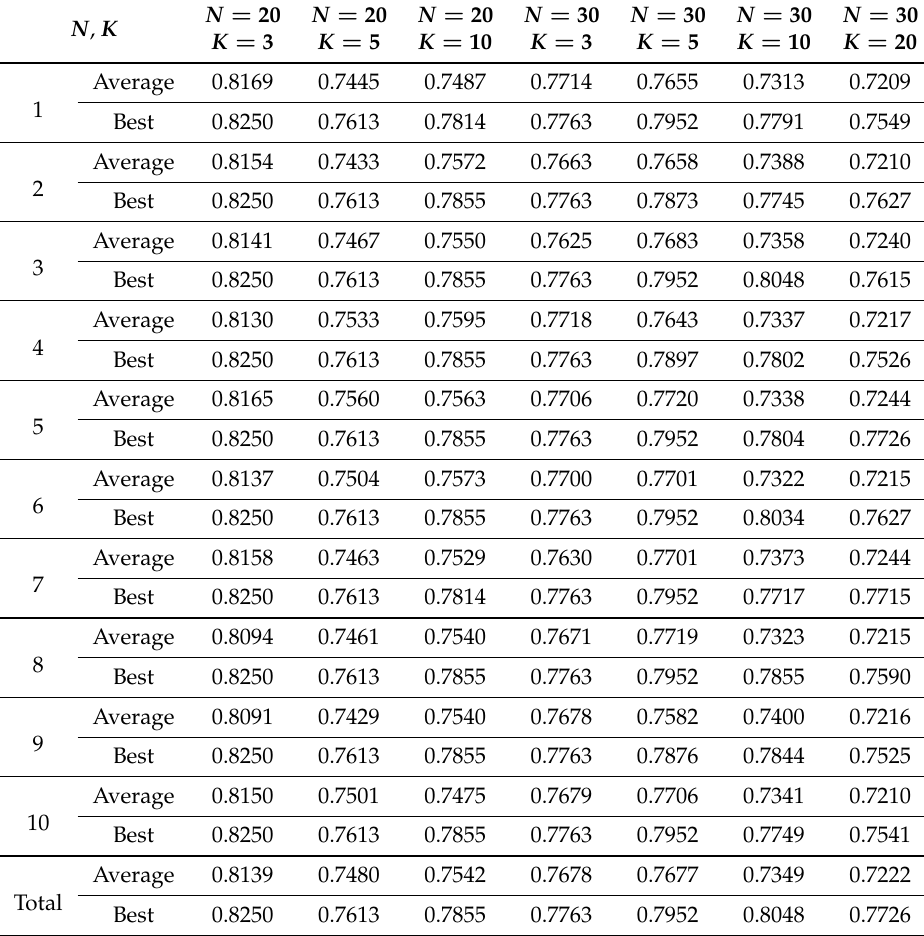
Figure 5. Comparison of processing time for the experiment in this study (“DNN”) and that in previous study (“Epistasis”) on the Variant-OneMax problem [41]. Table 5. Experimental results for the NK -landscape